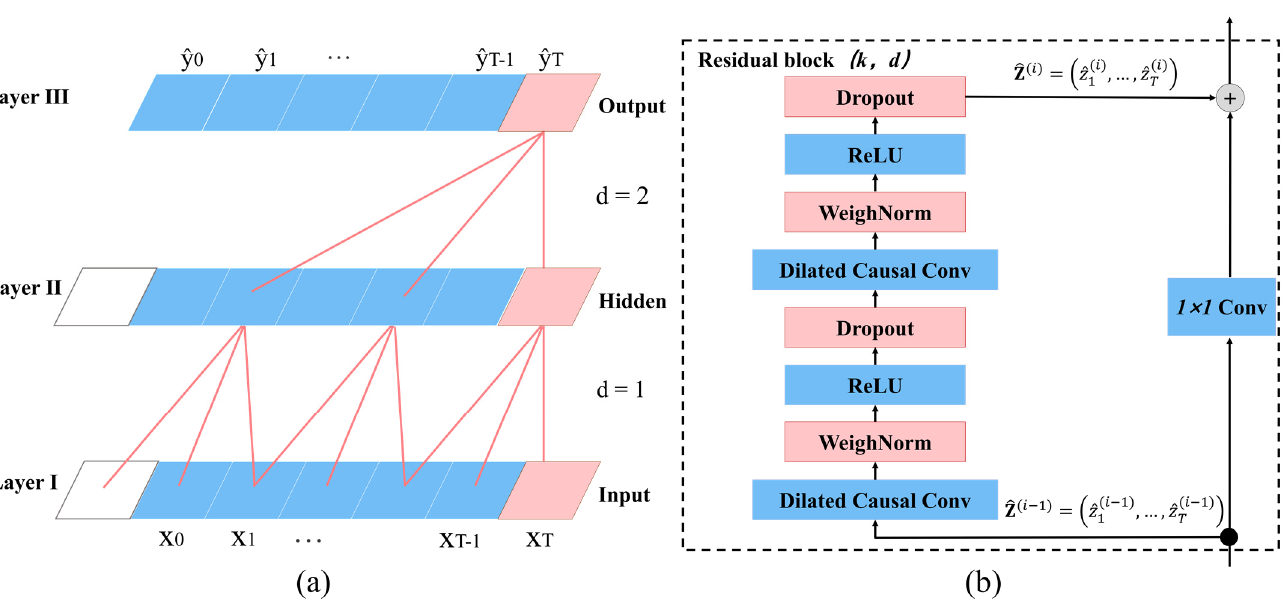
Figure 3. Architectural elements in a TCN. ( a ) A dilated causal convolution with dilation factors d = 1, 2. The perceptual field is able to cover all values of the input sequence. ( b ) When the remaining inputs and outputs have different sizes, a 1 × 1 convolution is added. Inputs and outputs have different sizes.